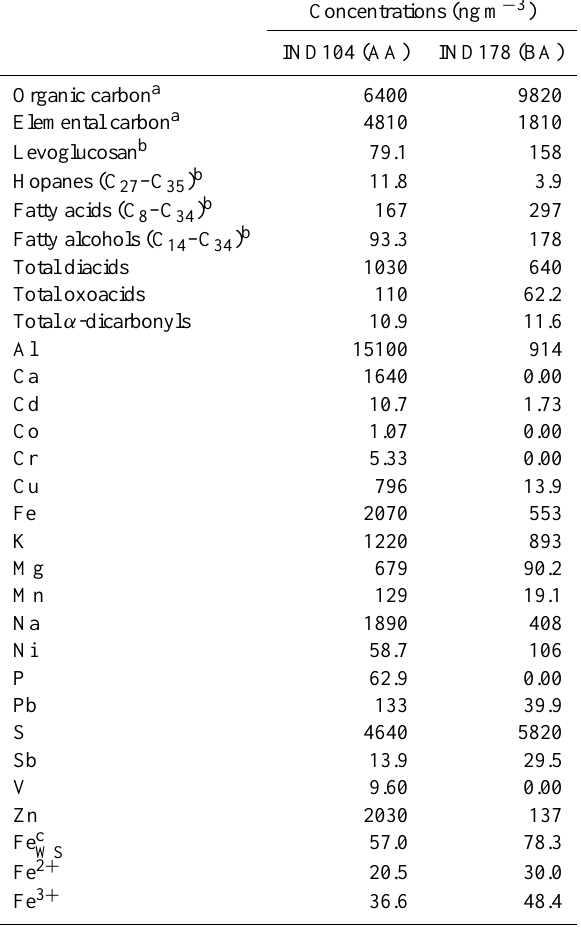
Table 1. Concentrations of carbonaceous components, organic molecular tracer compounds, diacids and related compounds, trace elements, metals and water-soluble iron species in non-irradiated IND104 (anthropogenic aerosols: AA) and IND178 (biogenic aerosols: BA) aerosol samples collected from Chennai,